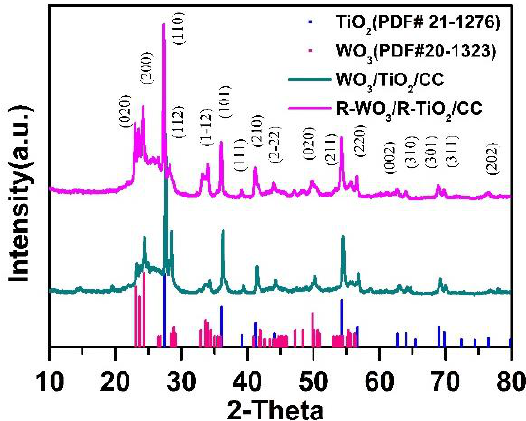
Figure 1. XRD pattern of WO 3 /TiO 2 /CC and R-WO 3 /R-TiO 2 /CC composite.